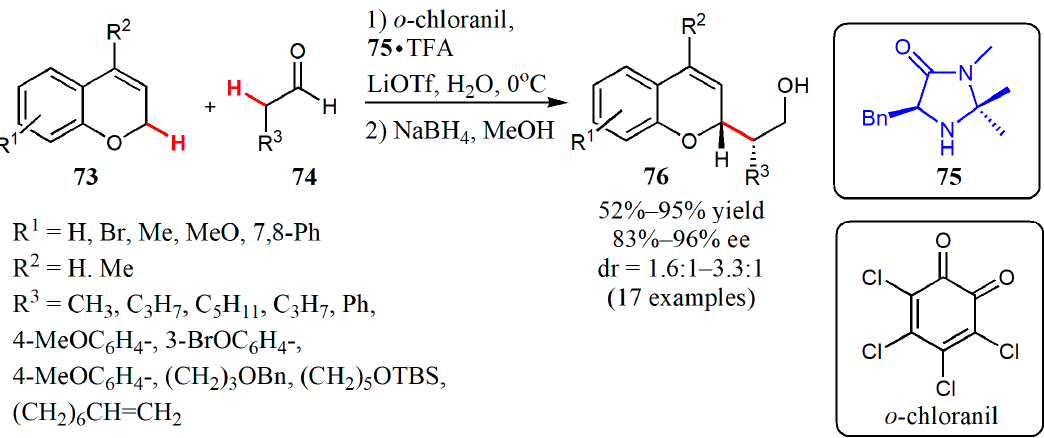
Figure 21. Catalytic asymmetric CDC of 2 H -chromenes and aldehydes.